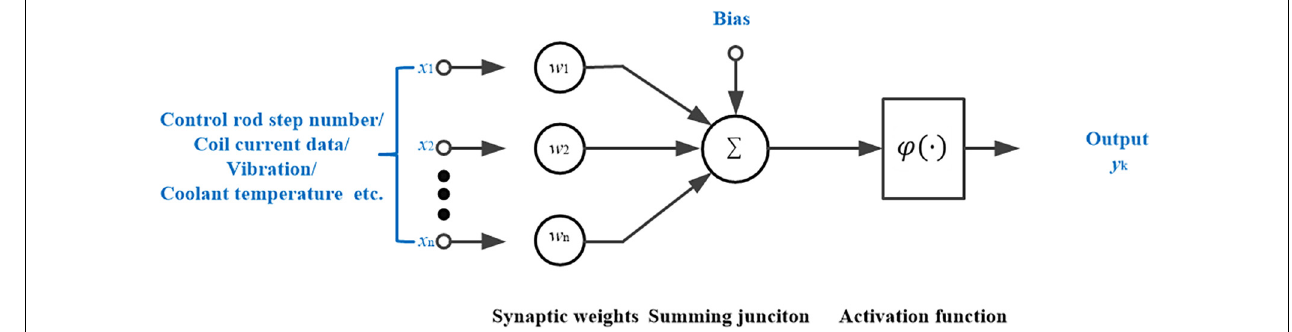
FIGURE 2 | The artificial neural network (ANN) approach for the fault diagnosis and detection (FDD) in the nuclear power plant (NPP).